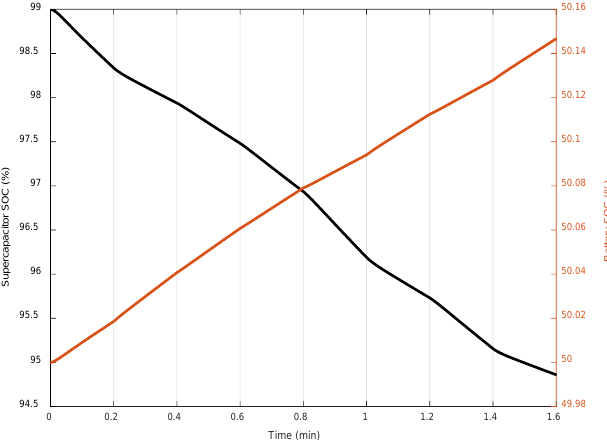
Figure 15. State of charge (SOC) of supercapacitor and battery.